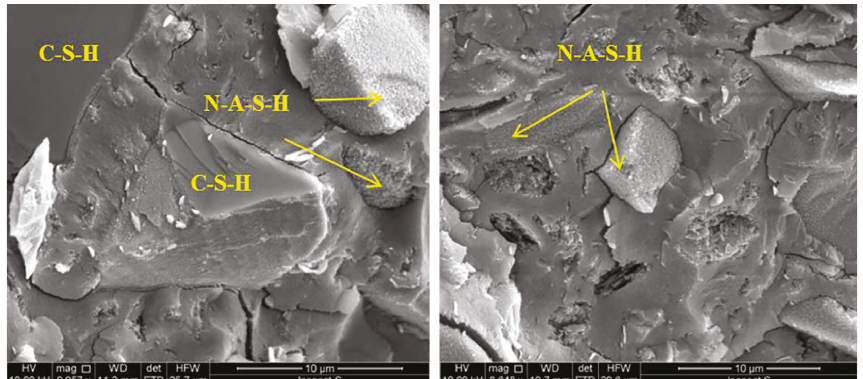
Figure 14: The SEM images for 85GMS geopolymer paste at 35 curing days.